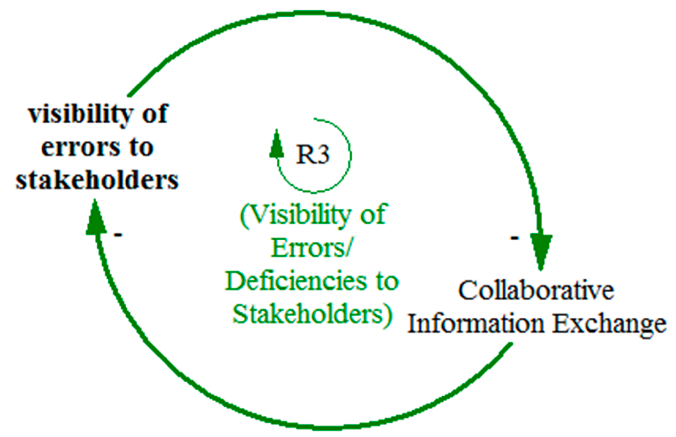
Figure 8. Reinforcing loop R3 (visibility of errors/deficiencies to stakeholders).